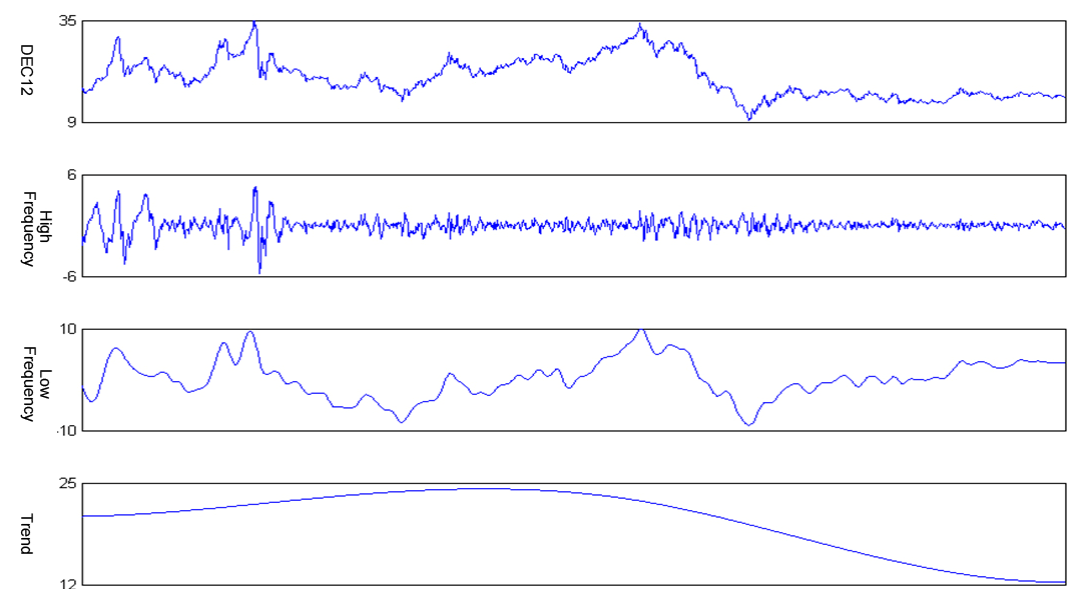
Figure 7. The reconstruction of DEC12 derived from